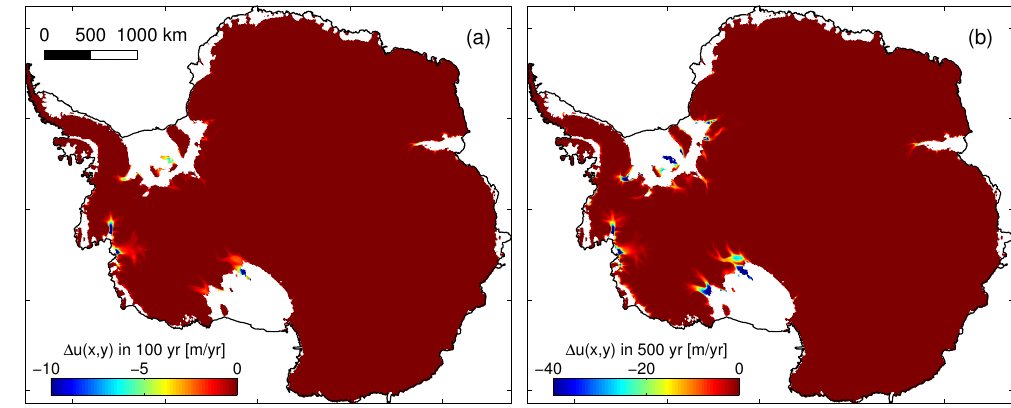
Figure 8. Influence of GIA uplift on the ice surface velocities. Change in ice surface velocity, 1u(x,y) , due to the predicted bed uplift at (a) AD 2100 and (b) AD 2500. Calculations are made by running the diagnostic simulation of the 3-D ice flow (higher-order) capability of ISSM. Other model setup and boundary conditions are consistent with those of the SeaRISE control experiment (cf. Bindschadler et al., 2013). A systematic reduction in velocity, which can be attributed partly to the reduction in τ d (x,y) (around the Amundsen Sector and the Amery Ice Shelf; cf. Fig. 6) and partly to the GL advance (particularly in the large ice shelves; cf. Fig. 7), indicates the stabilizing effects of GIA uplift on the future dynamics of